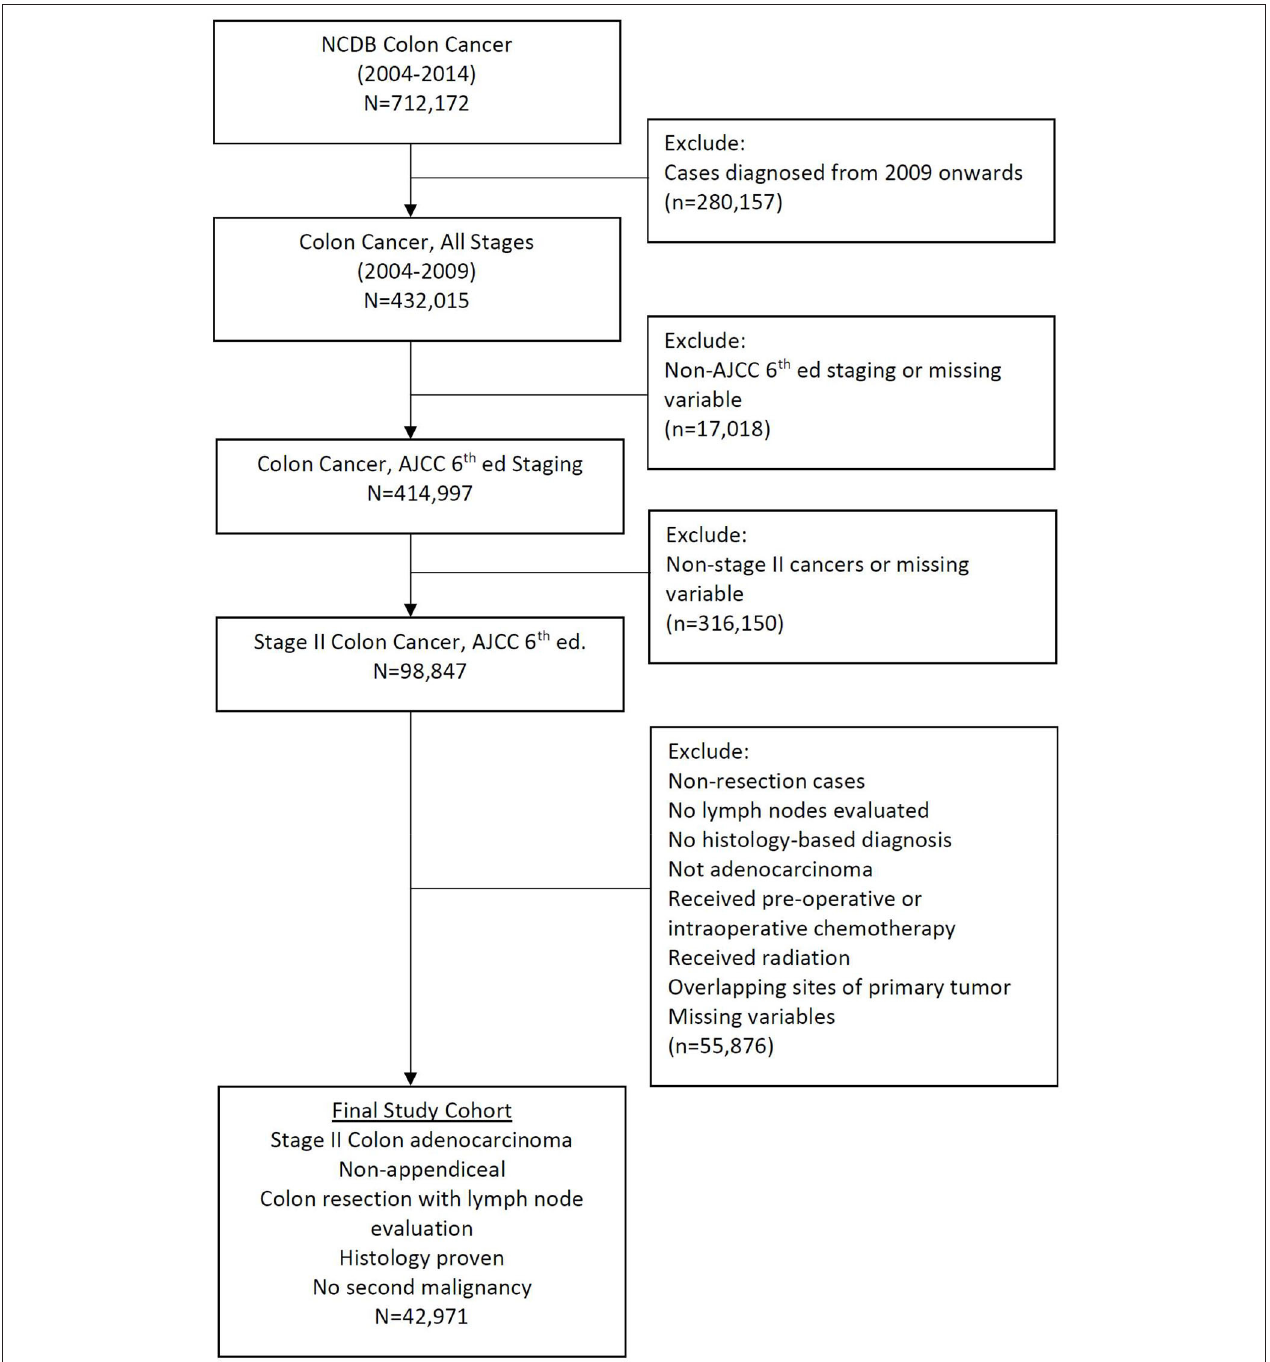
FIGURE 1 | CONSORT